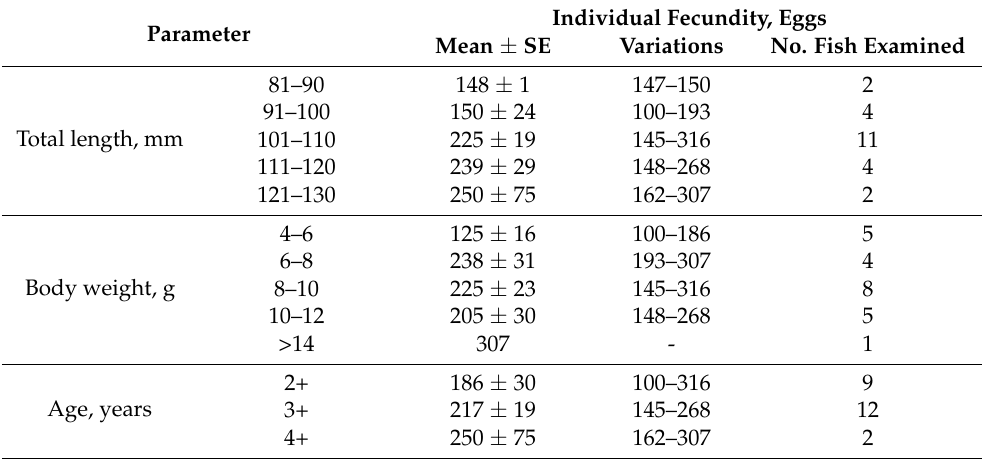
Figure 6. Female ( top , photo courtesy Andrei Dolgov) and male ( bottom , photo by A.M. Orlov) ribbed sculpin Triglops pingelii (black arrow points to anal papilla). Table 3. Changes of individual fecundity of ribbed sculpin Triglops pingelii in the Kara Sea with increase of total length, body weight, and age (SE = standard